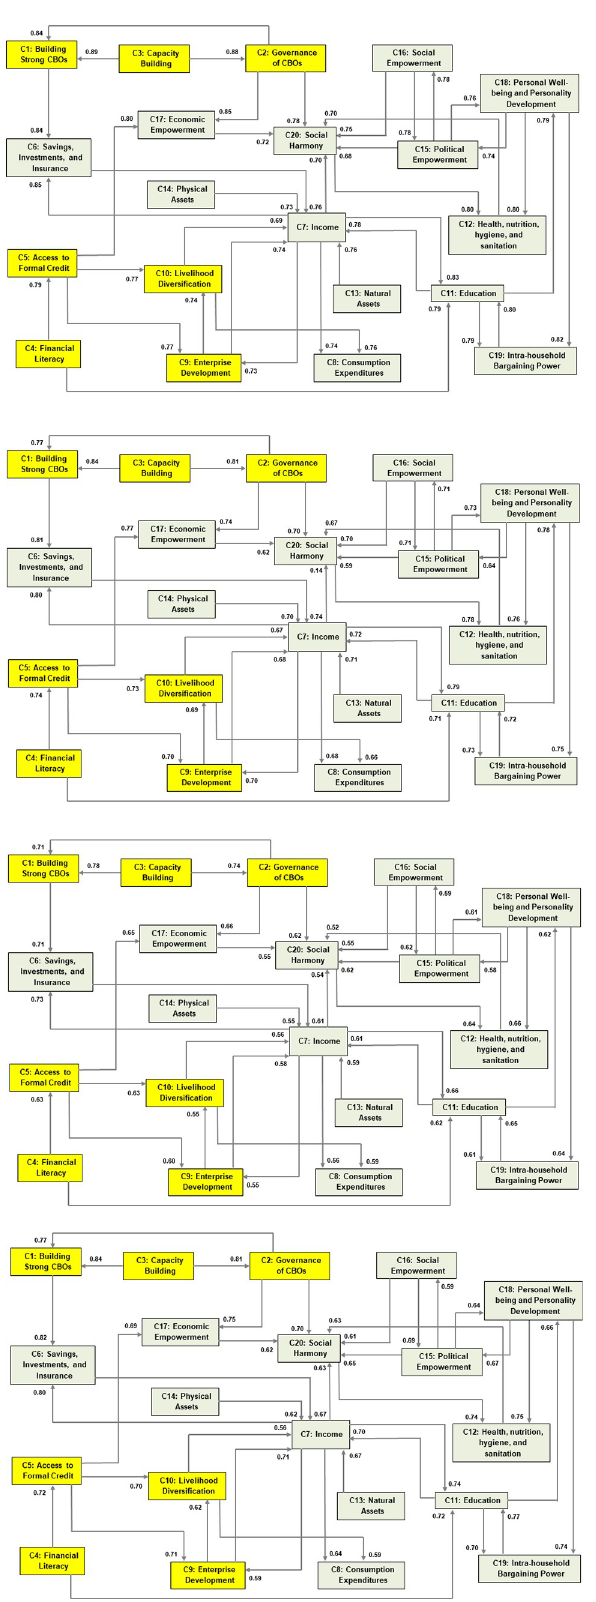
Fig 5. (a) Collective-FCM model for Average-FCM (L). (b) Collective-FCM model for OWA-FCM (L). (c) Collective- FCM model for Average-FCM (C). (d) Collective-FCM model for OWA-FCM (C).